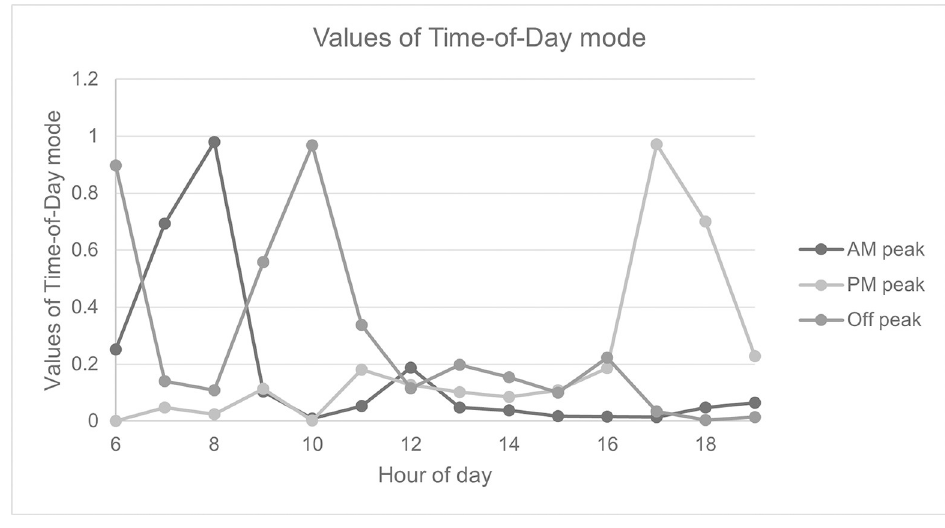
Fig 11. Values of a factor matrix for time-of-day